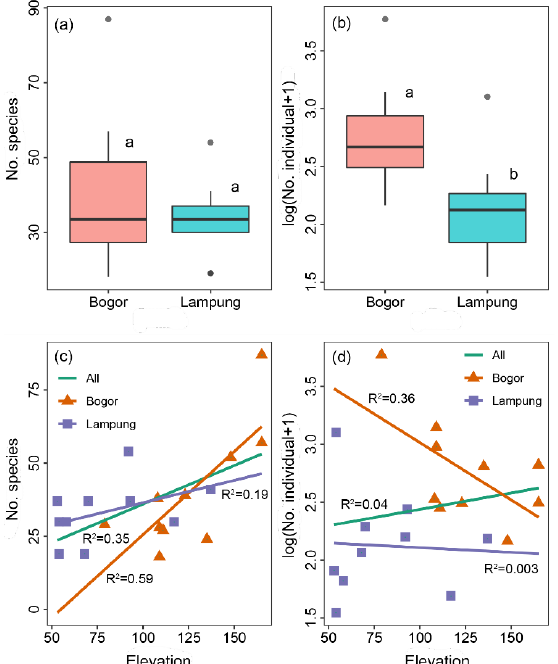
Figure 3. Di ff erence of ( a ) species richness and ( b ) individual of insects between Bogor and Lampung and the relationship between elevation (m above sea level) and ( c ) species number and ( d ) individual insects. Data of insect individual were transformed to log(x + 1) to achieve normal distribution. Boxplots with di ff erent letters was significantly di ff erent at p < 0.05 according to Tukey’s test. Based on ANOSIM, we found that the similarity of insect species composition was significantly different between regions (R = 0.39, p = 0.002) and as visualized in the ordination results of the NMDS analysis, also separated between Bogor and Lampung (Figure 4a). By contrast, the species composition of insects between land-use types did not differ (R = −0.05, p = 0.718), indicated by the overlap of plot groups within a region (Figure 4b).